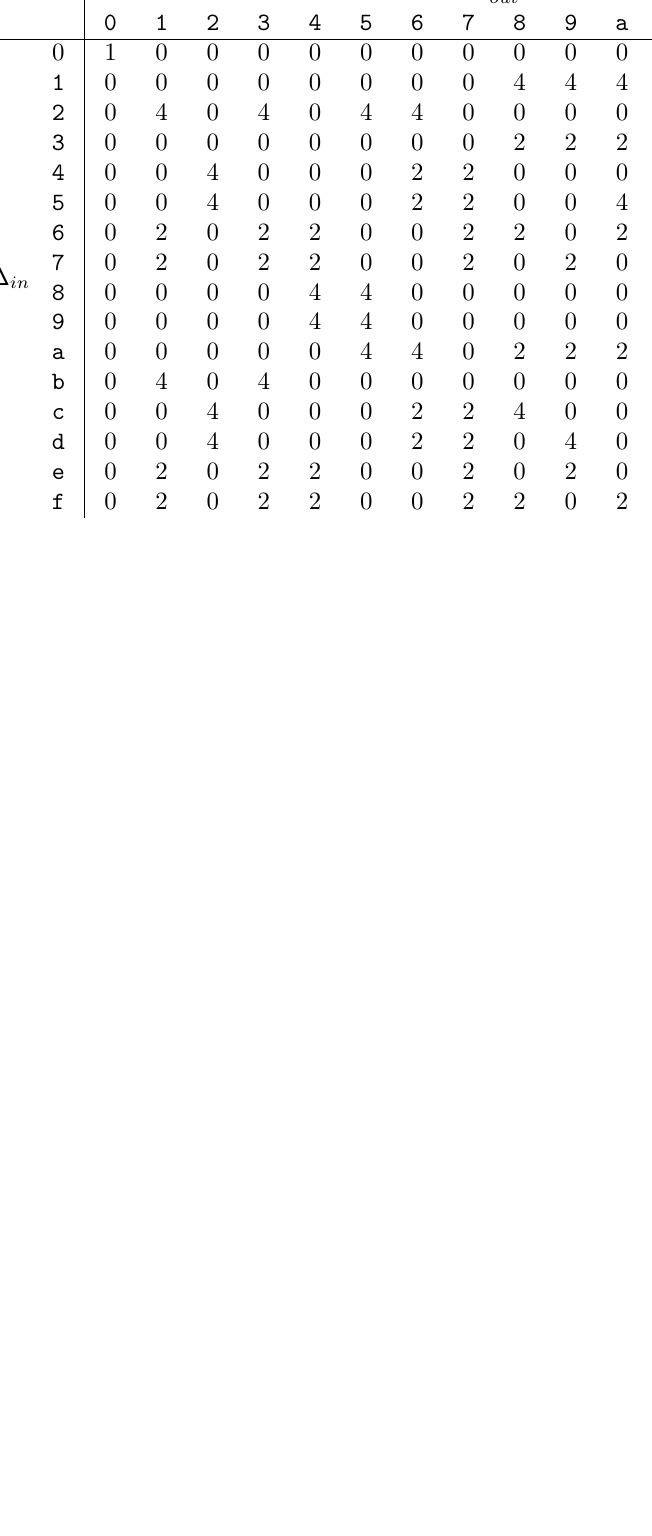
Table 8: The DDT of the SKINNY-64 Sbox, where ∆ in (resp. ∆ out ) represents the input (resp. output) difference in hexadecimal notation. Each entry provides the number of input values valid with regards to the differential transition ∆